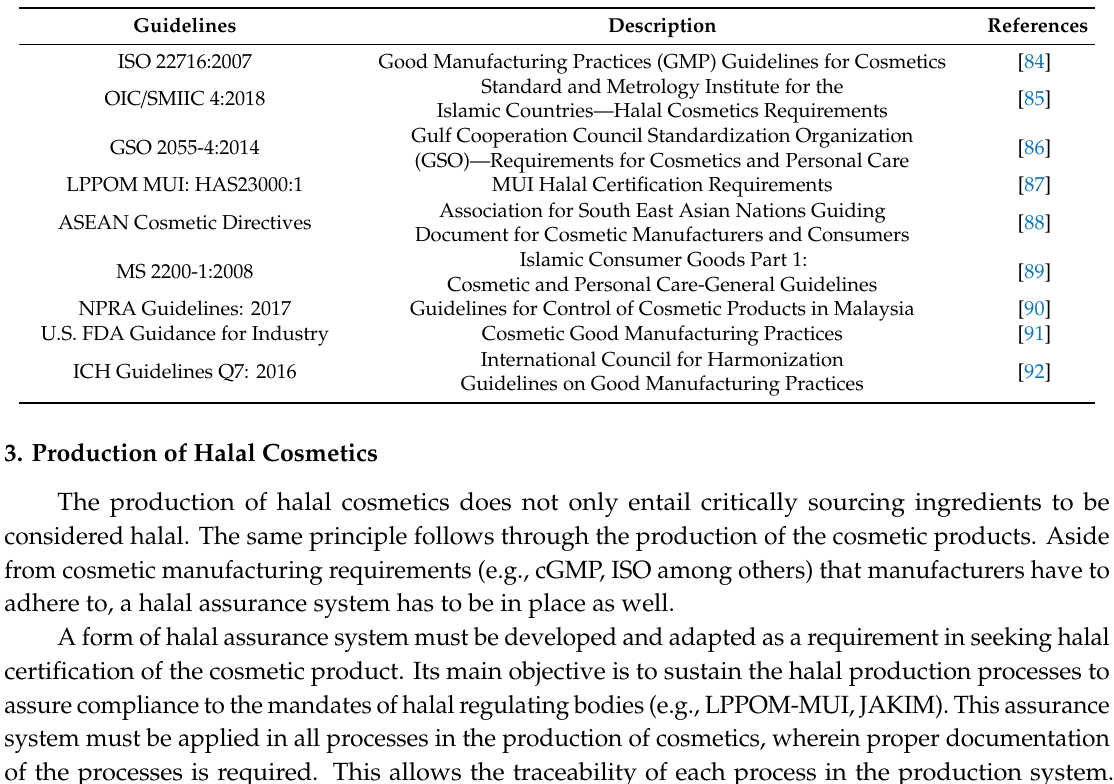
Table 4. List of guidelines for cosmetic production.